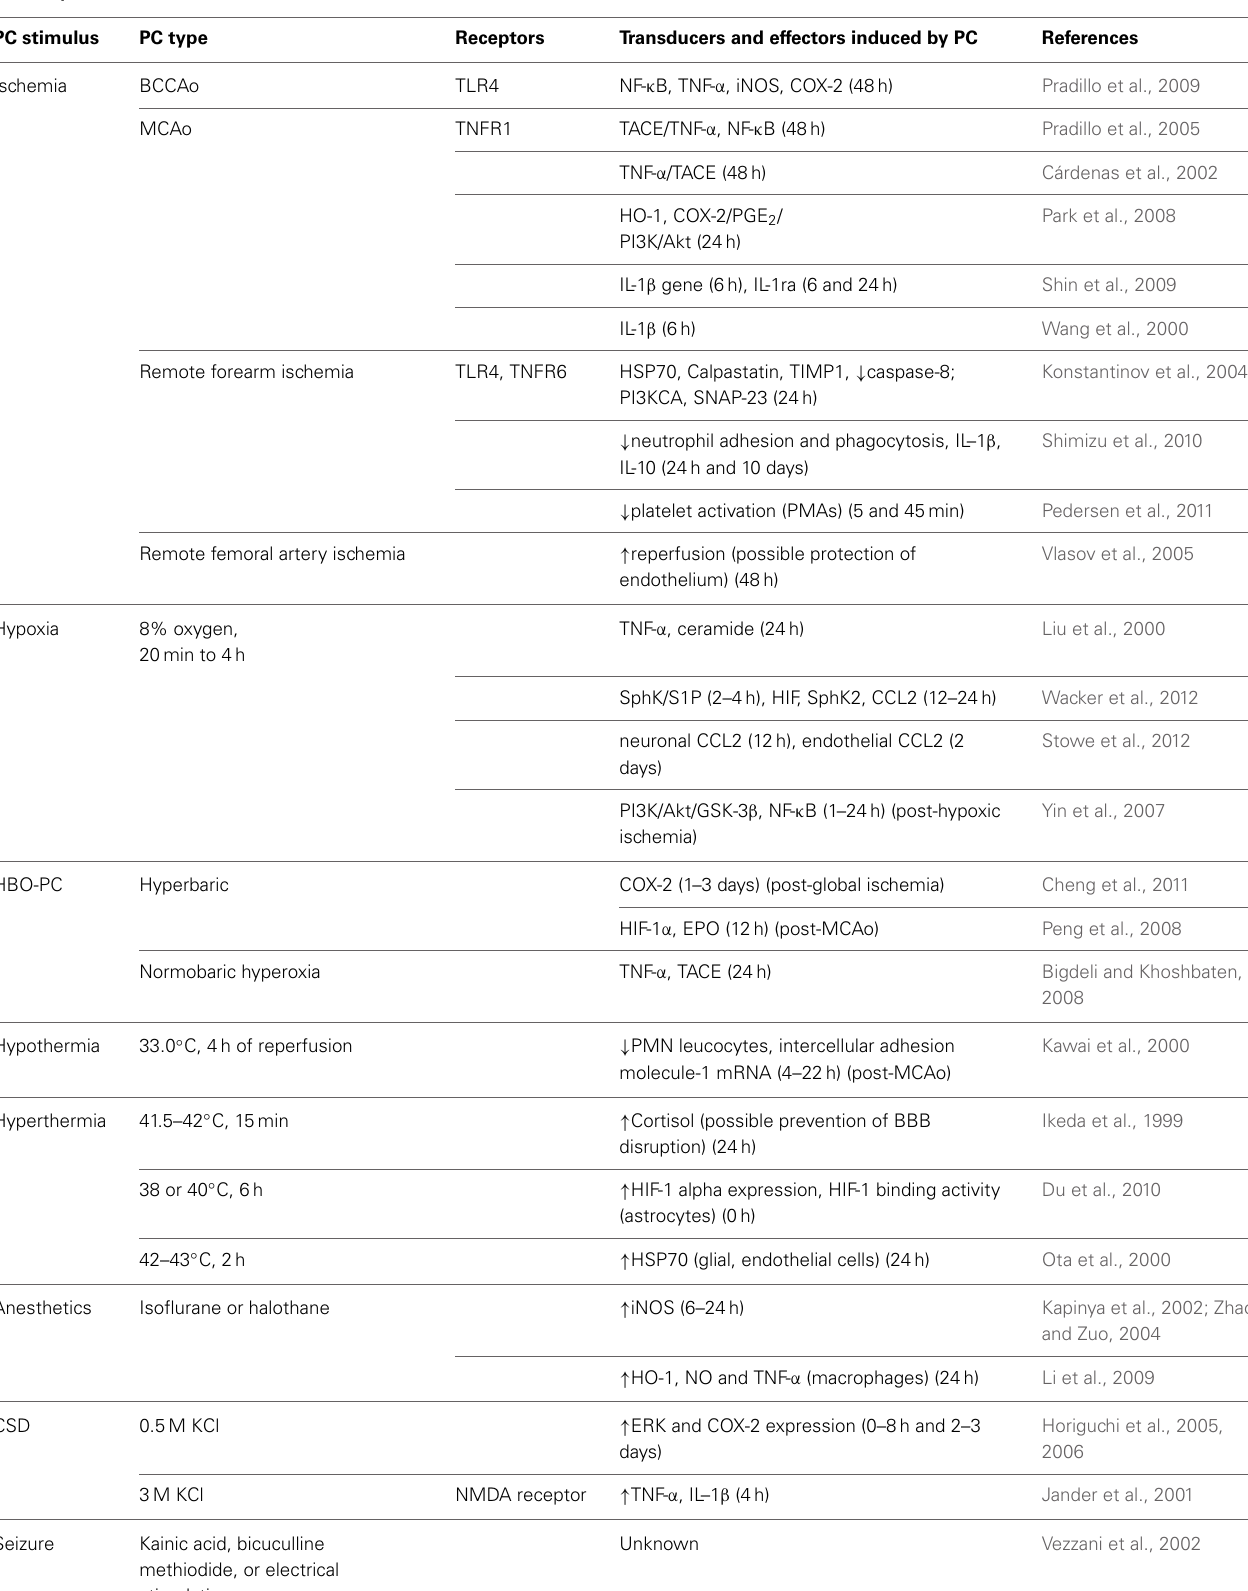
Table 2 | Molecular inflammatory mechanisms of brain